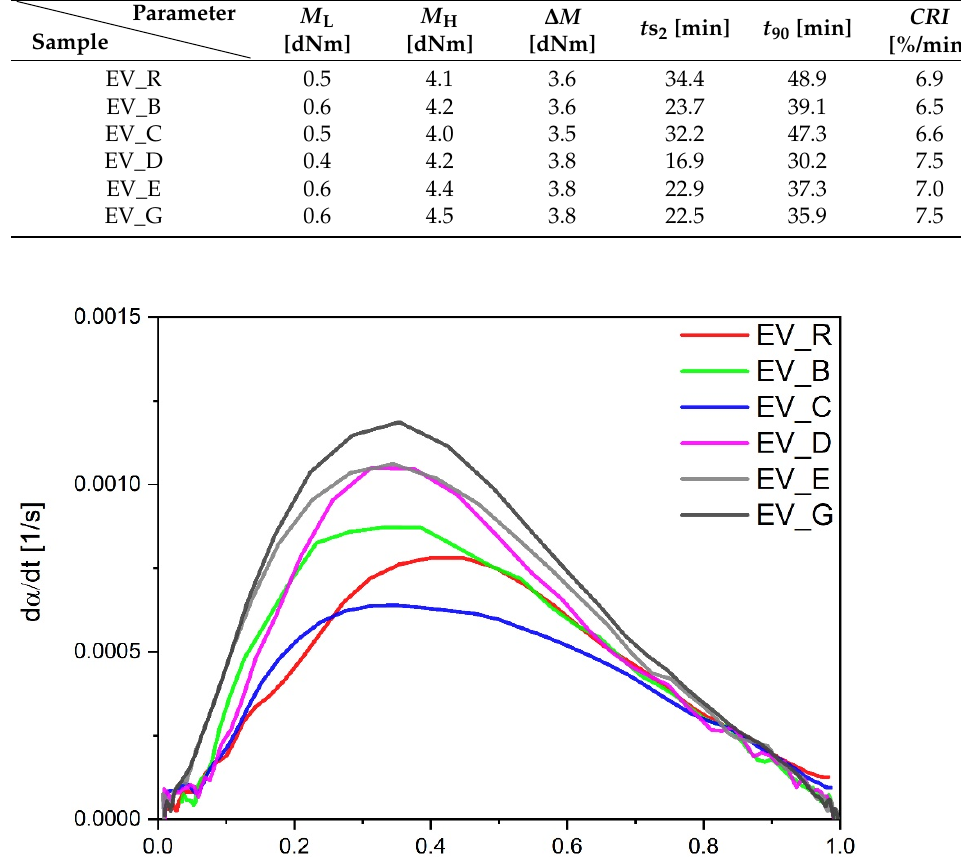
Figure 5. Activation energy for the vulcanization of rubber compounds prepared in the EV sys- tem. EV_...—rubber compounds containing n-ZnO in the effective curing system; EV_R—refer- ence rubber compound containing standard ZnO in the effective curing system.